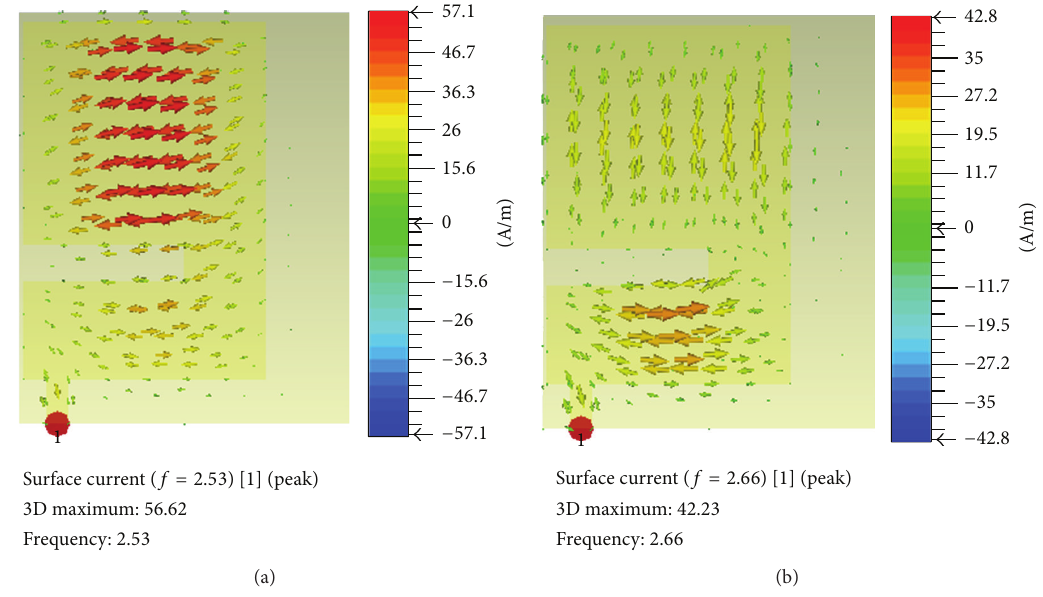
Figure 5: Surface current on the patch at (a) 2.53 GHz and (b) 2.66